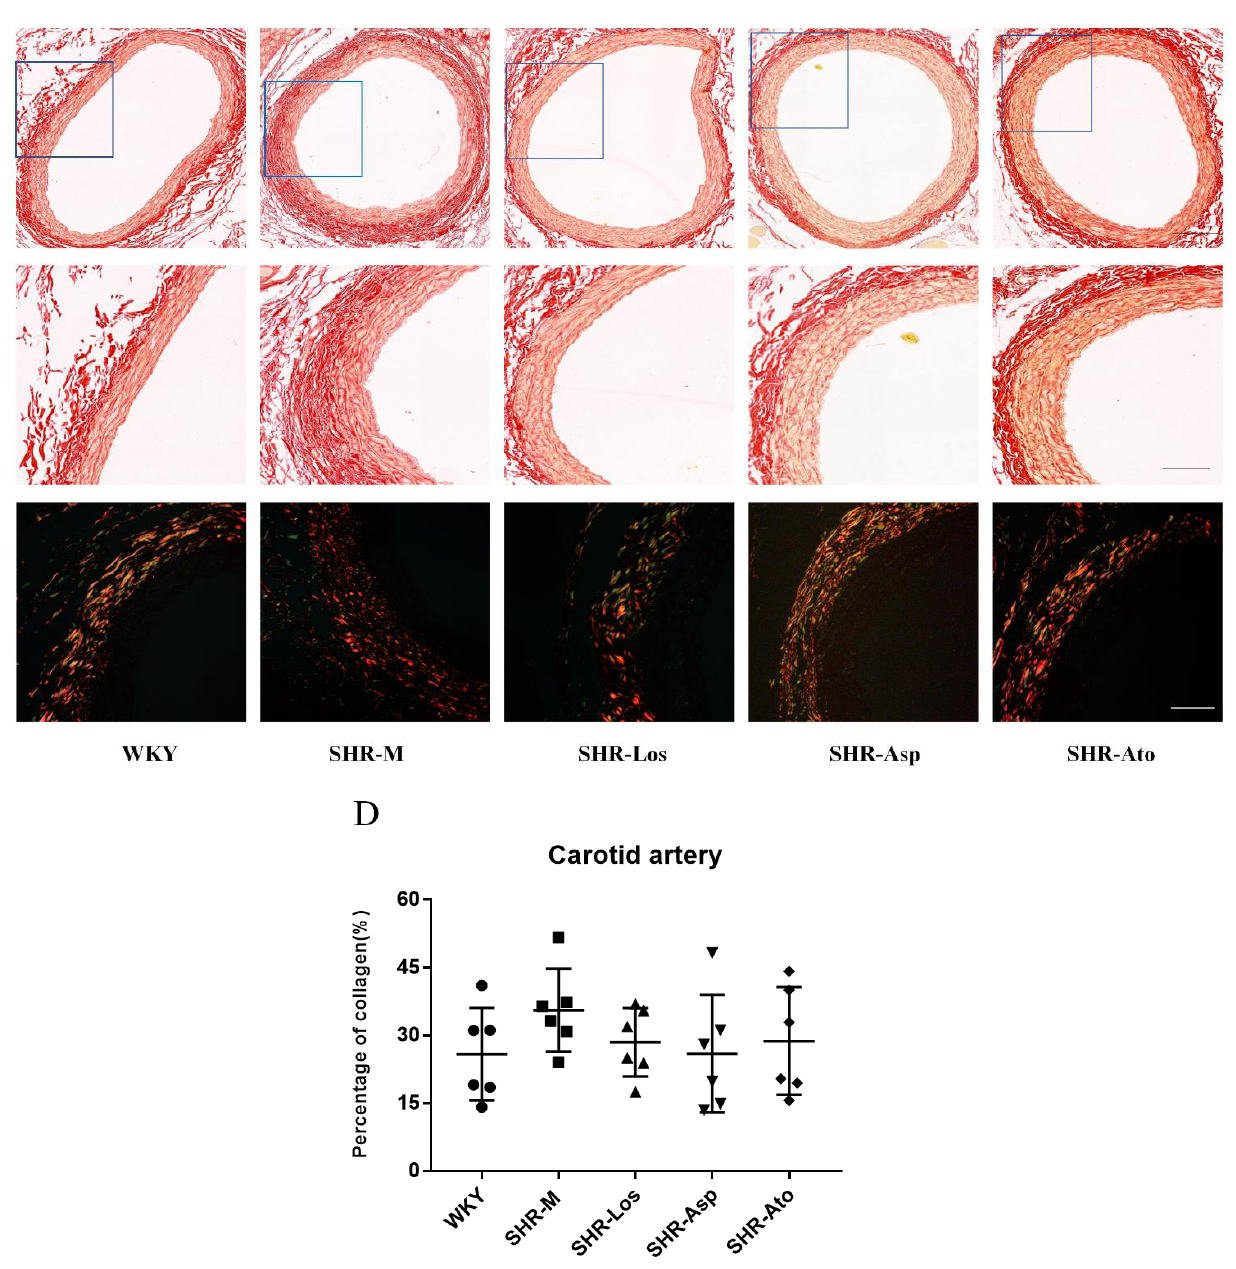
Figure 5. The distribution of collagen in cross sections of carotid arteries (22 weeks rats). ( A ) Sirius Red stain of collagen under optical microscope (scale bar = 200 μm); ( B ) magnified images of A (scale bar = 100 μm); ( C ) Sirius Red stain of collagen I and collagen III under polarized light microscopy, collagen I was bright red or strong orange–red, and collagen III was green (scale bar = 100 μm); ( D ) the percentage of collagen fibers in carotid arteries. The data are presented as the mean ± SD. n = 6.